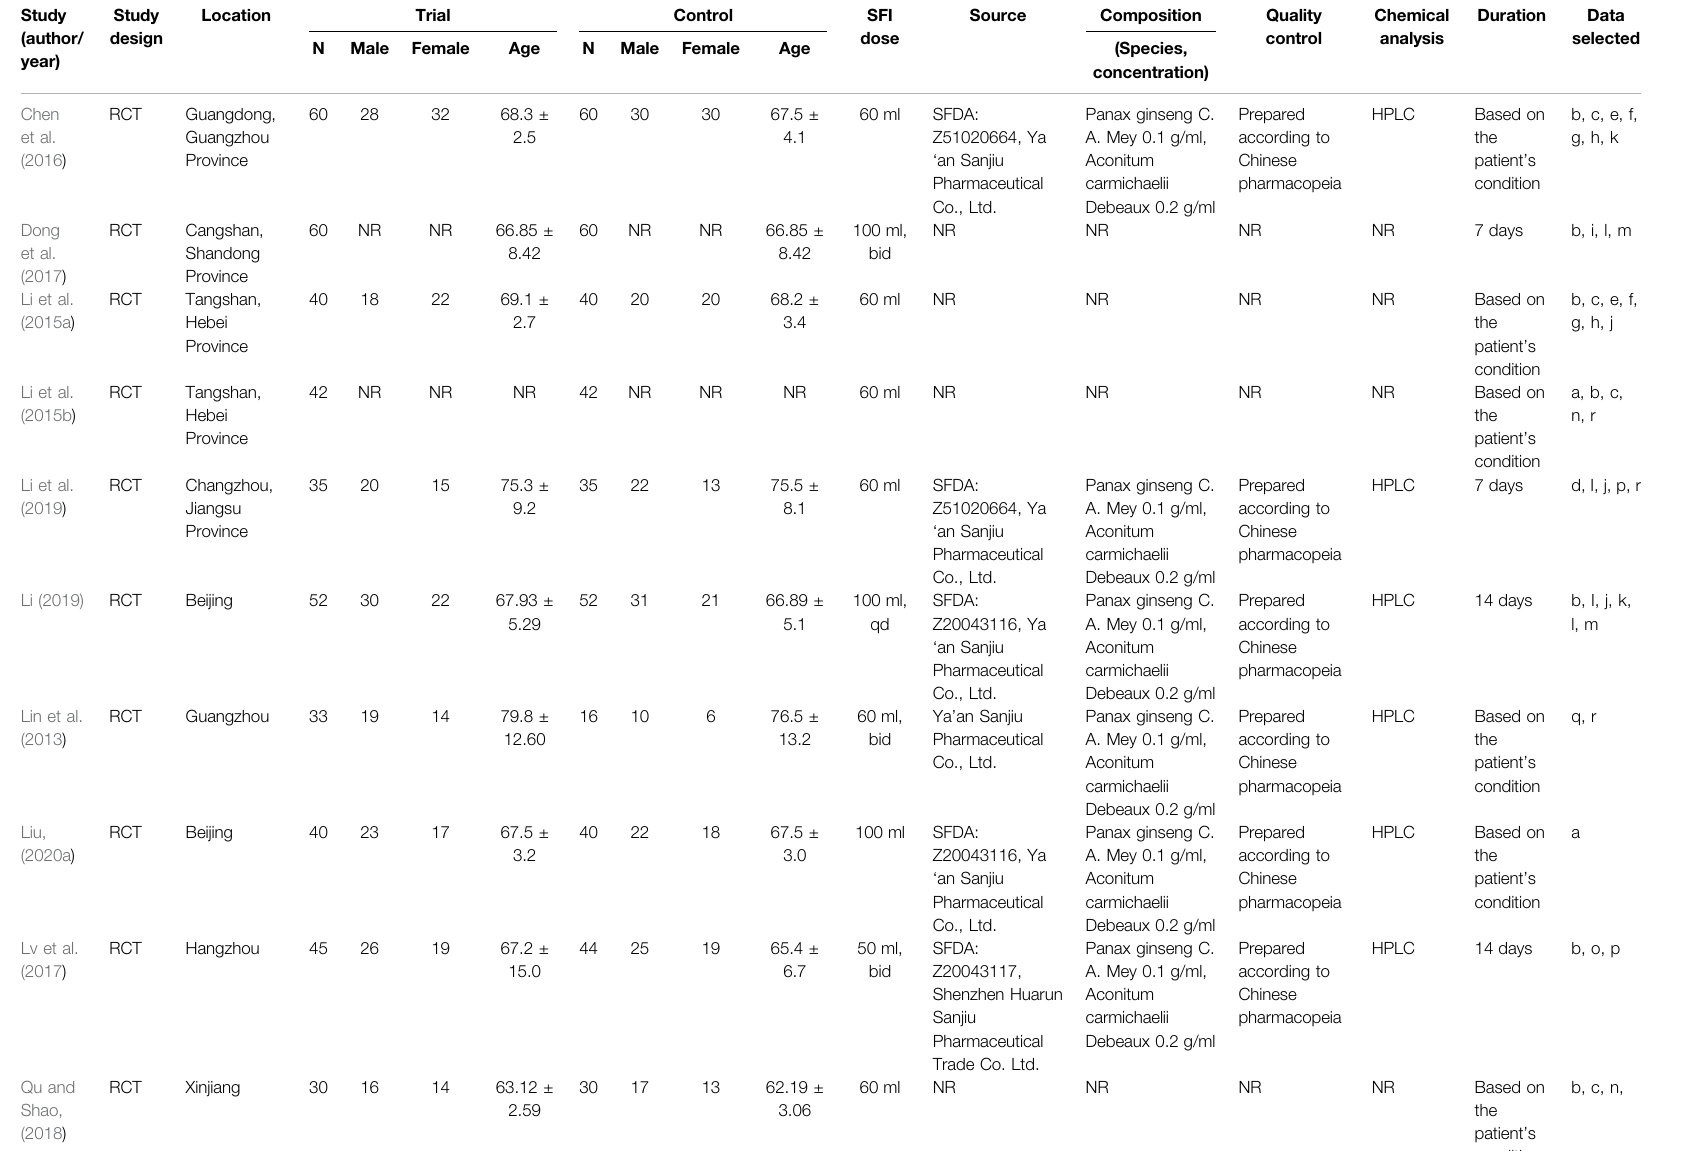
TABLE 2 | Summary of the eligible studies included in the